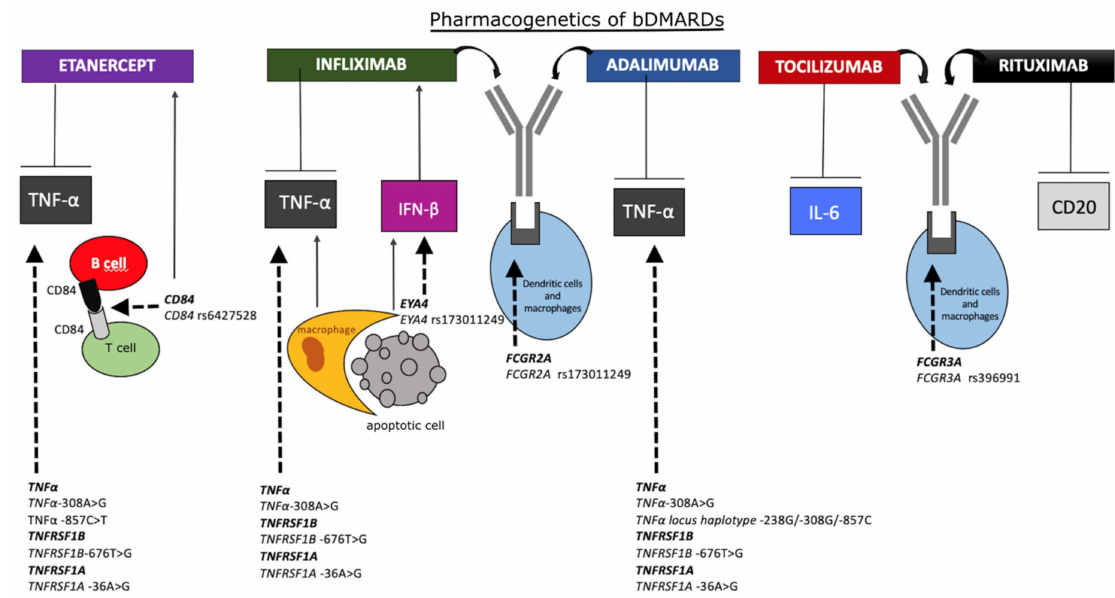
Figure 2. Schematic representation of the main pharmacogenetic biomarkers associated with bDMARDs treatment. Rheumatoid arthritis (RA) patients with tumor necrosis factor α (TNF α )-308 G / G